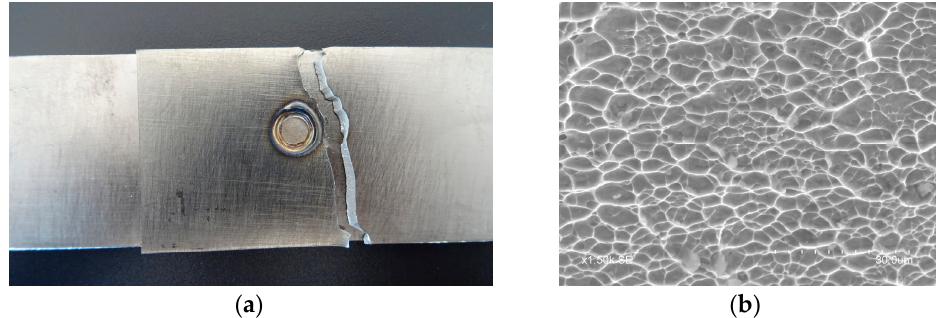
Figure 9. Pullout failure mode: ( a ) Fracture appearance; and ( b ) SEM observation of the fracture surface.